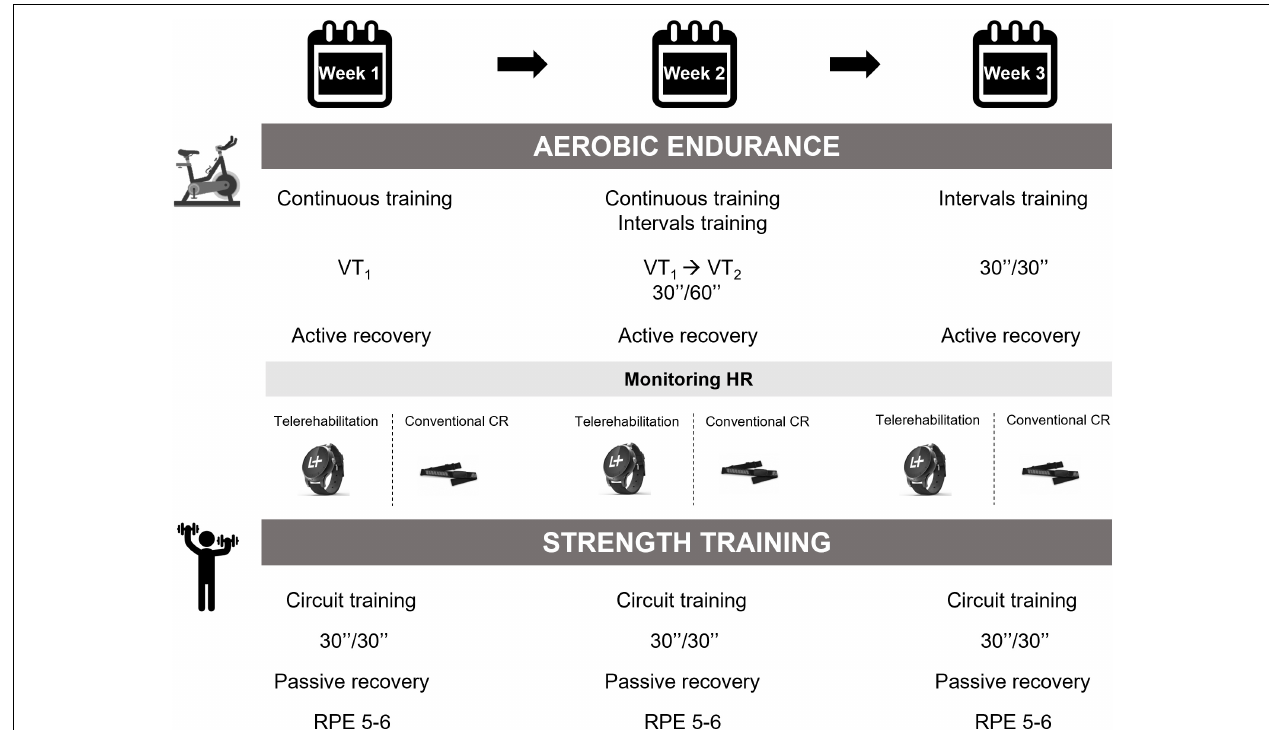
FIGURE 3 | Physical exercise intervention. VT, ventilatory threshold; HR, heart rate; CR, cardiac rehabilitation; RPE, rating of perceived exertion.